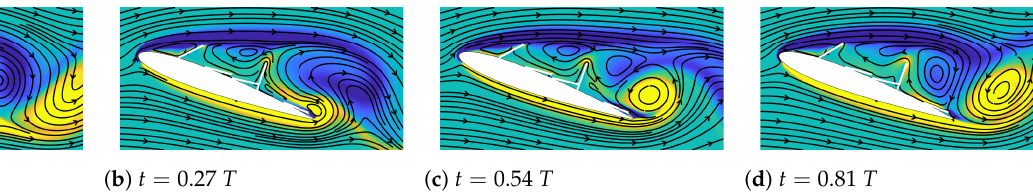
Figure 13. Vorticity contours at different time instants in one period of lift cycle for the case of k β = 0.00025 and i β = 0.001.